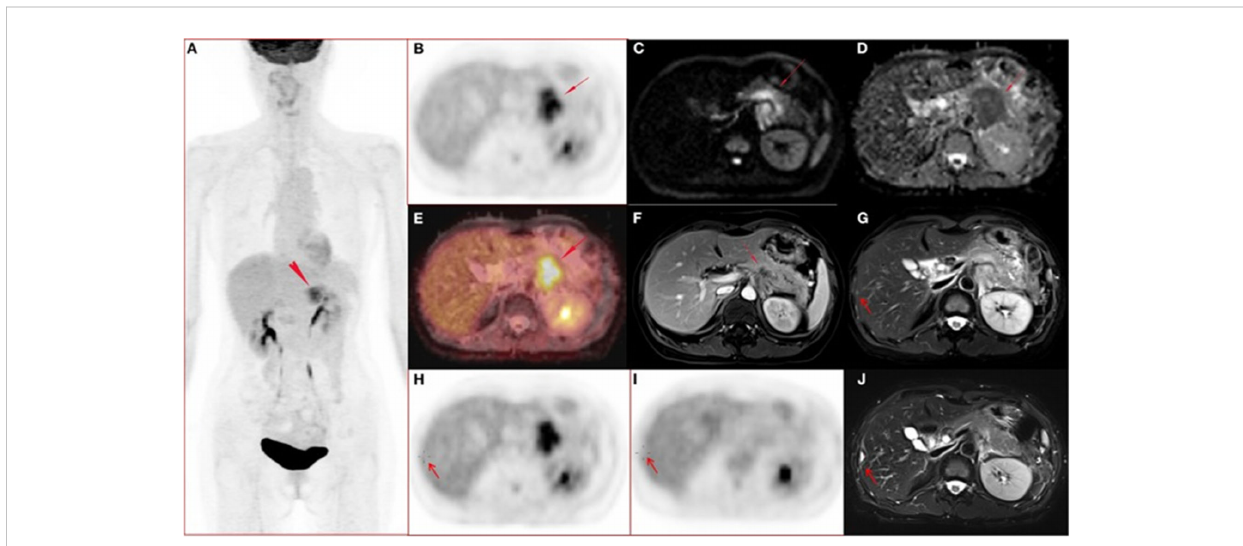
FIGURE 2 A 51-year-old woman with ductal adenocarcinoma in the body-caudal junction of the pancreas with liver metastases (31). (A-J) Whole body PET images; (A) maximum intensity projection (MIP); (B) transverse abdominal PET images showing increased FDG metabolism in pancreatic body and tail lesions with SUVmax of 7.52, SUVmean of 6.39, and MTV of 17.43 cm3. (C, D) Diffusion-weighted imaging (DWI, b = 800) and apparent diffusion coef fi cient (ADC) showed diffusion-limited lesions in the pancreatic body and tail. (E) Fusion image of PET and ADC showing diffusion-restricted lesions with high FDG metabolism. (F) Arterial late fat-suppressed (fs) contrast-enhanced (CE) T1-weighted image (T1WI) showing hypovascular disease and dilated main pancreatic duct with a lesion measuring 4.7 cm in maximum diameter. (G, H) Right hepatic lobe metastasis (arrow) con fi rmed by surgery (2 days after initial PET/MRI) and histopathological examination, with mildly hyperintense lesions on T2WI and no FDG uptake on PET images. (I-J) 112-day postoperative PET/MRI follow-up showed that the T2WI in the surgical area was markedly hyperintense, and the FDG uptake in PET images was